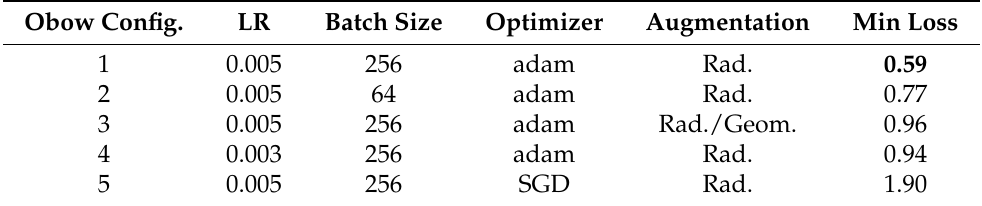
Table 4. An overview of the OBoW configuration. We can observe that the best configuration is reached with a strong radiometric augmentation. The other hyperparameters are in line with those proposed in [12].